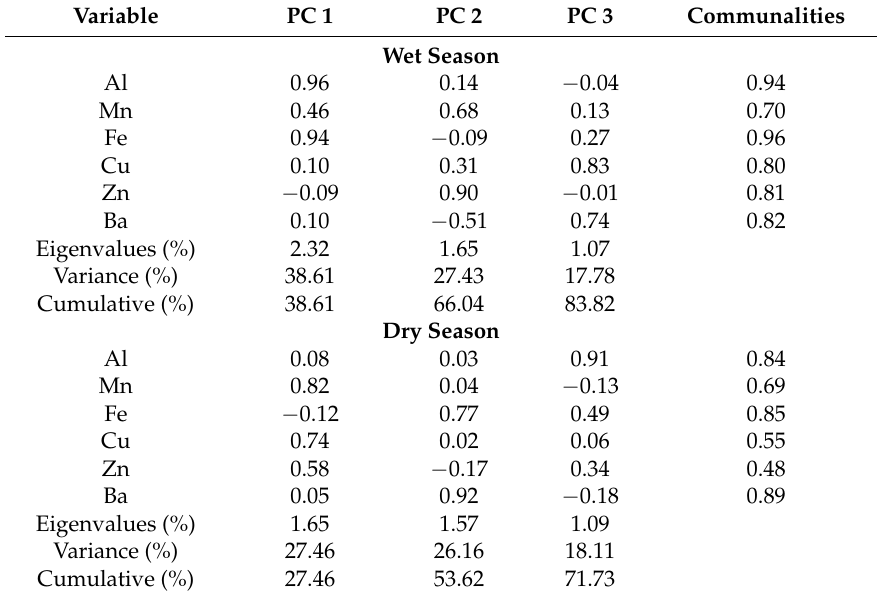
Table 5. Varimax rotated component matrix for the dissolved heavy metals in the Mun River.